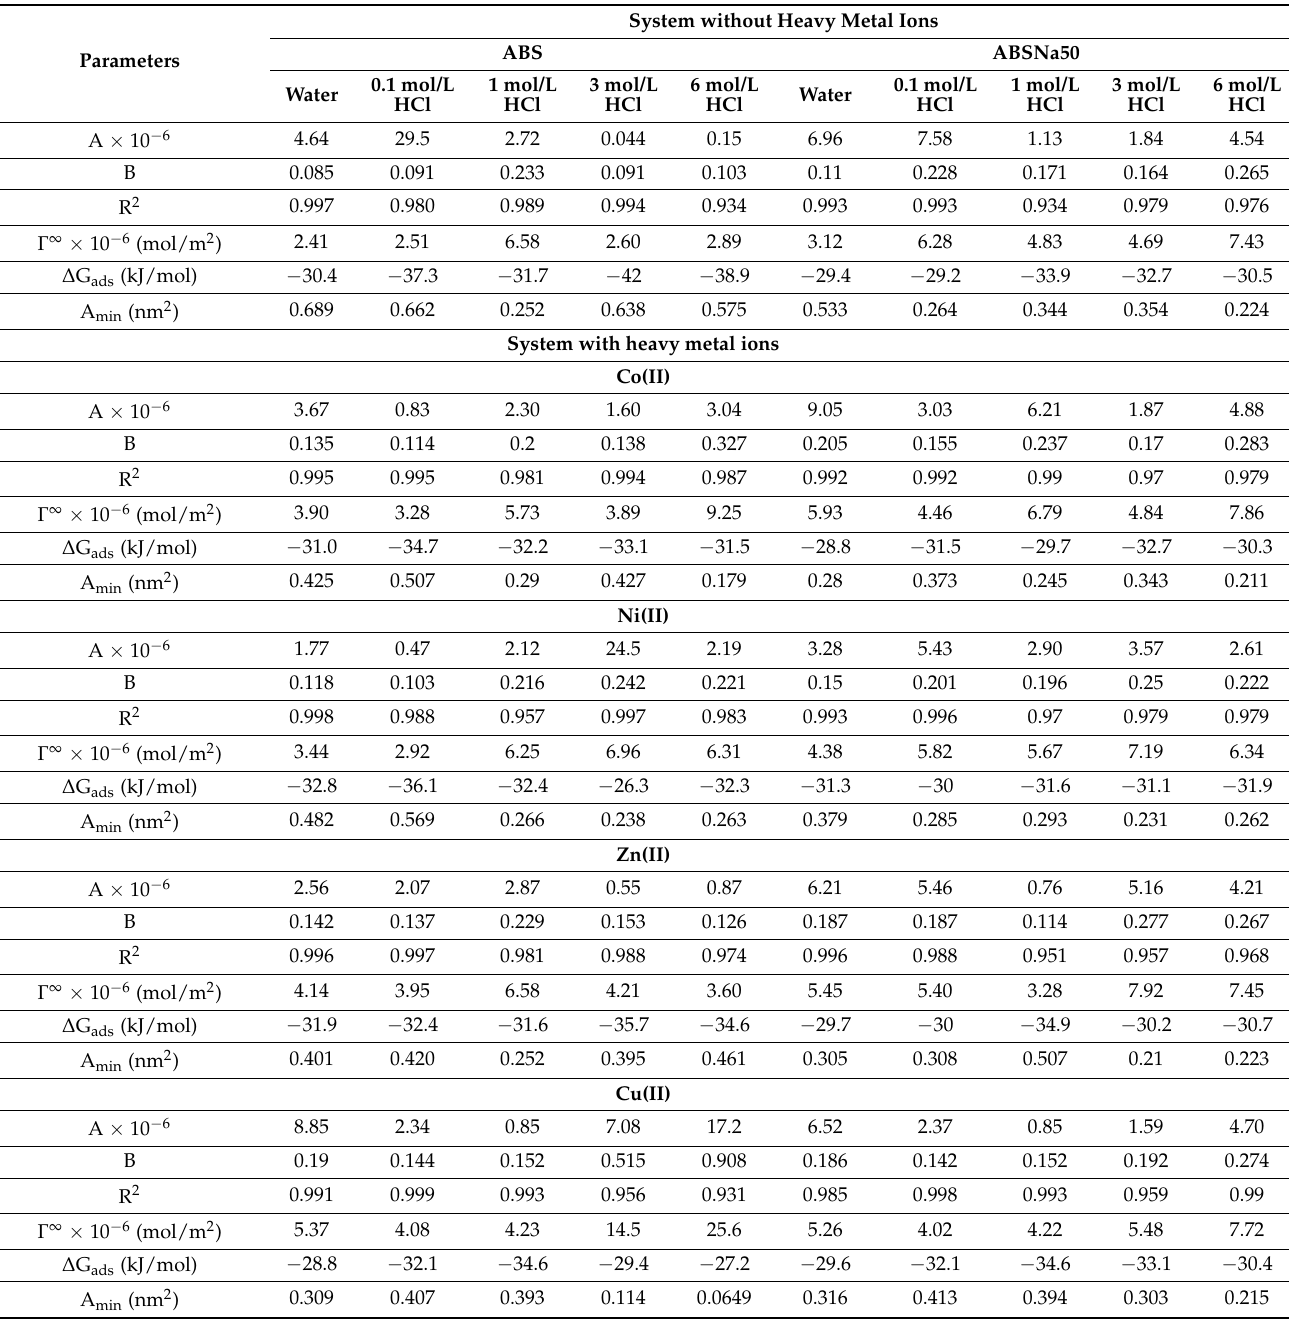
Table 2. Adsorption parameters obtained in the water–AS–M(II)/air or HCl–AS–M(II)/air